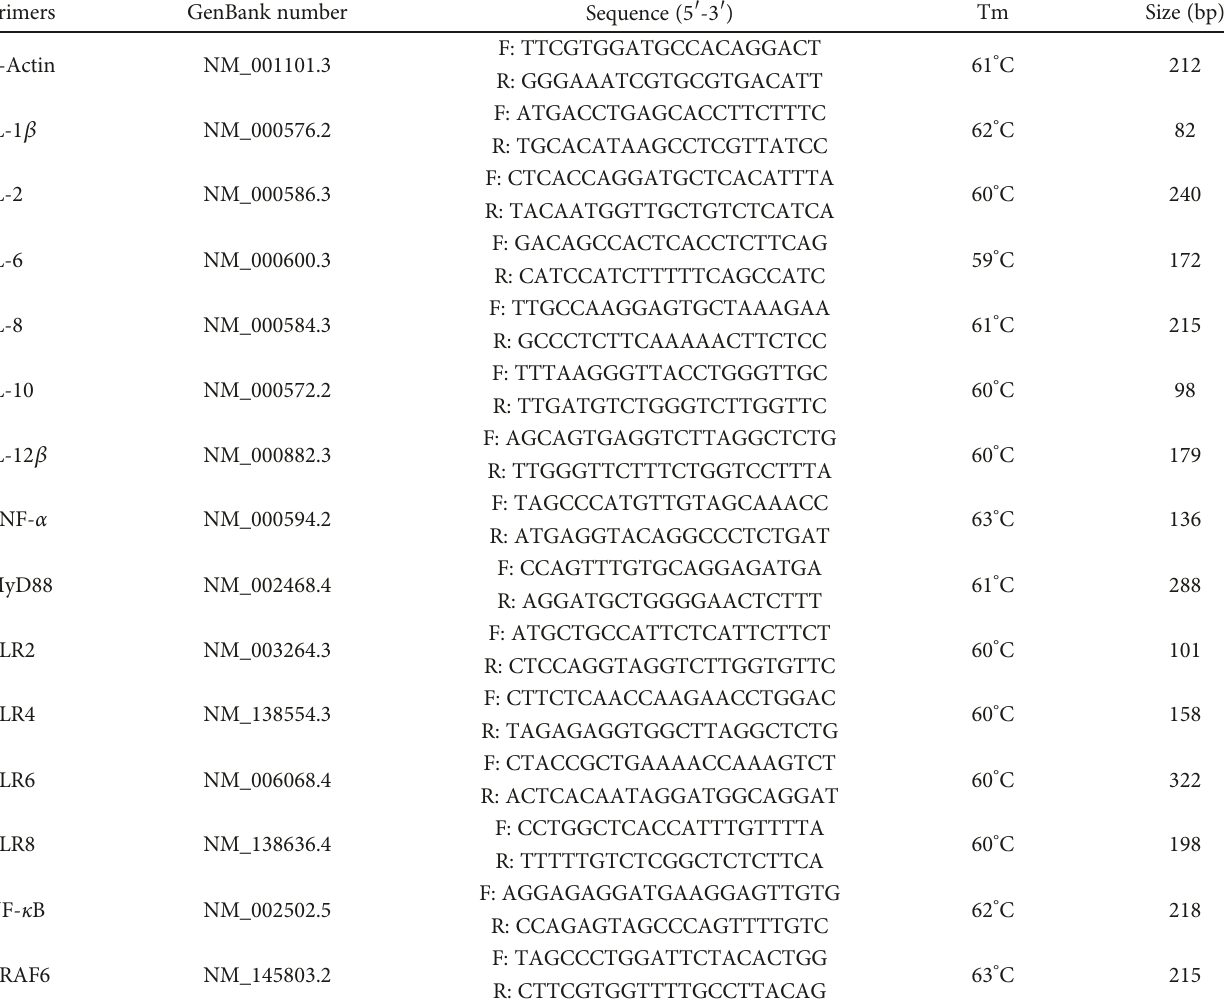
Table 1: The real-time qRT-PCR primers used in this